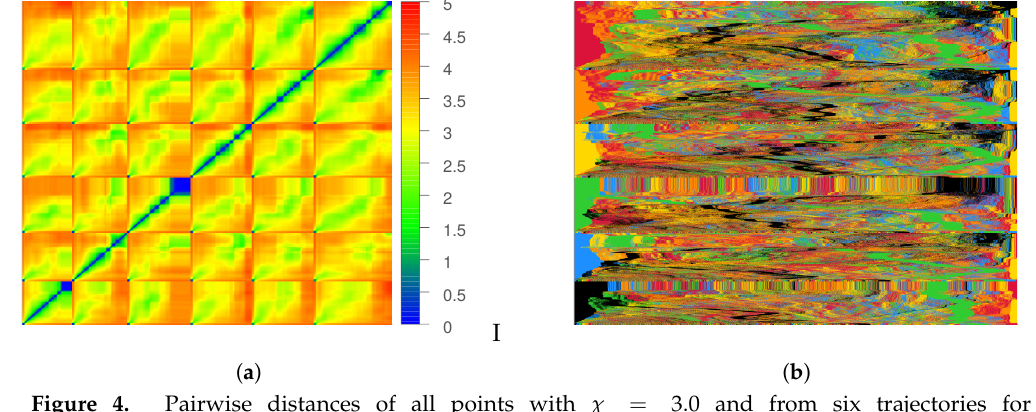
Figure 4. Pairwise distances of all points with χ = 3.0 and from six trajectories for φ ∈ { 0.50,0.52,0.54,0.56,0.58,0.6 } visualized in two ways. (Please view in color). ( a ) Distance matrix D for all data grouped by φ and ordered by time step along both axes. Distances in subblocks along the main diagonal denote interpoint distances within a fixed φ -value trajectory. Off-diagonal subblocks highlight distance between points lying on disjoint trajectories. ( b ) Distance matrix D with rows grouped by φ and ordered by time step. Entries in row i are sorted by increasing distance from x i and colored according to their φ value. Clusters of similar color nearest the left edge reflect k -NN having common φ -value for sufficiently large k